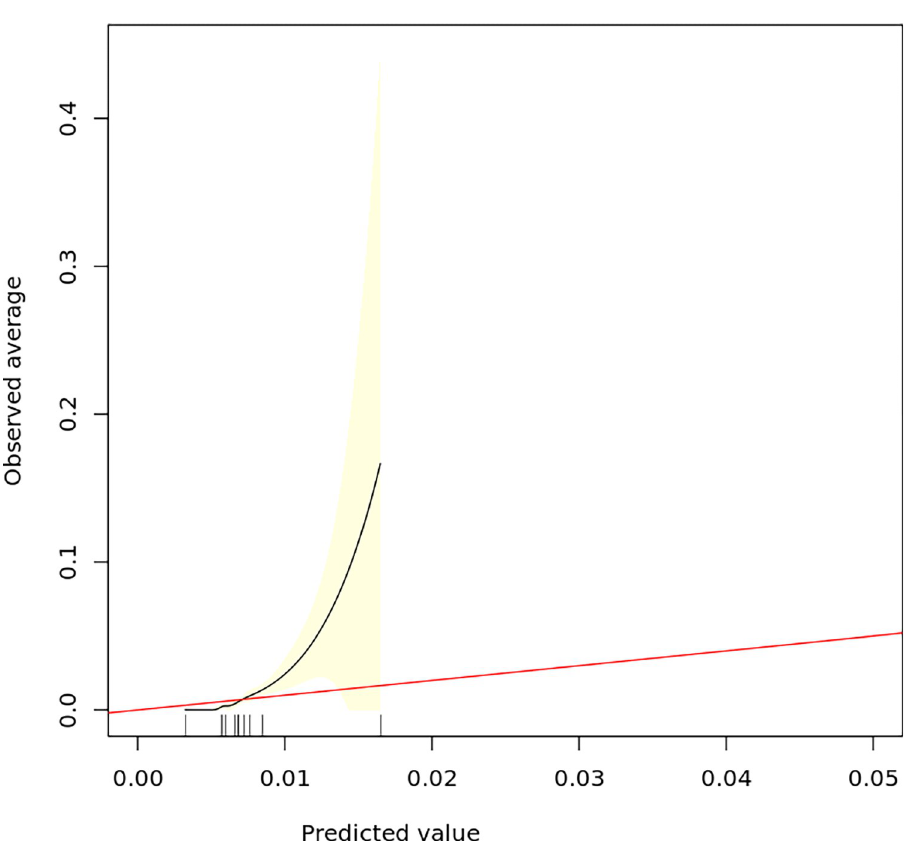
Fig 4. The calibration curve for the Model II (elastic net). On the x-axis are the predicted probabilities and on the y- axis are the observed probabilities. The predicted probability (black curve) moves farther from the true probability (red line) as the predicted value increases, indicating that the model underestimates the probability of dislocation for the patients having the highest probability of this outcome.